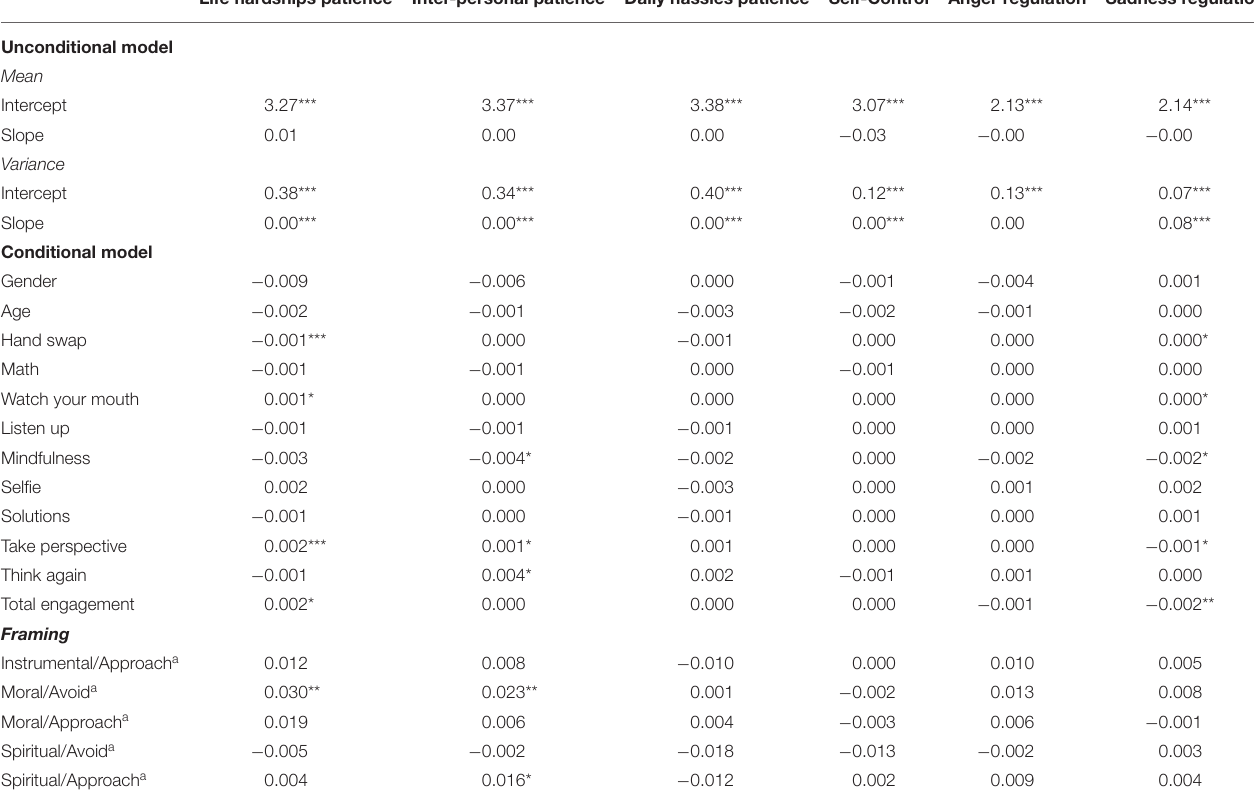
TABLE 3 | Parameter estimates for LGC